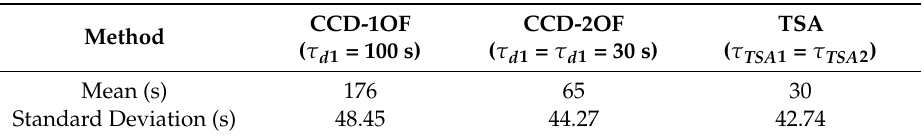
Figure 10. Comparison of the overall average response time to anomaly with respect to PRN. 5. Conclusions Ionospheric anomaly monitoring is an important integrity monitor procedure for GBAS. The contribution of this paper is to develop and test a new ionospheric anomaly monitoring algorithm by using the GPS receiver, which overcomes the traditional CCD monitoring methods that the estimation accuracy and response time to anomaly cannot be improved simultaneously with a fixed